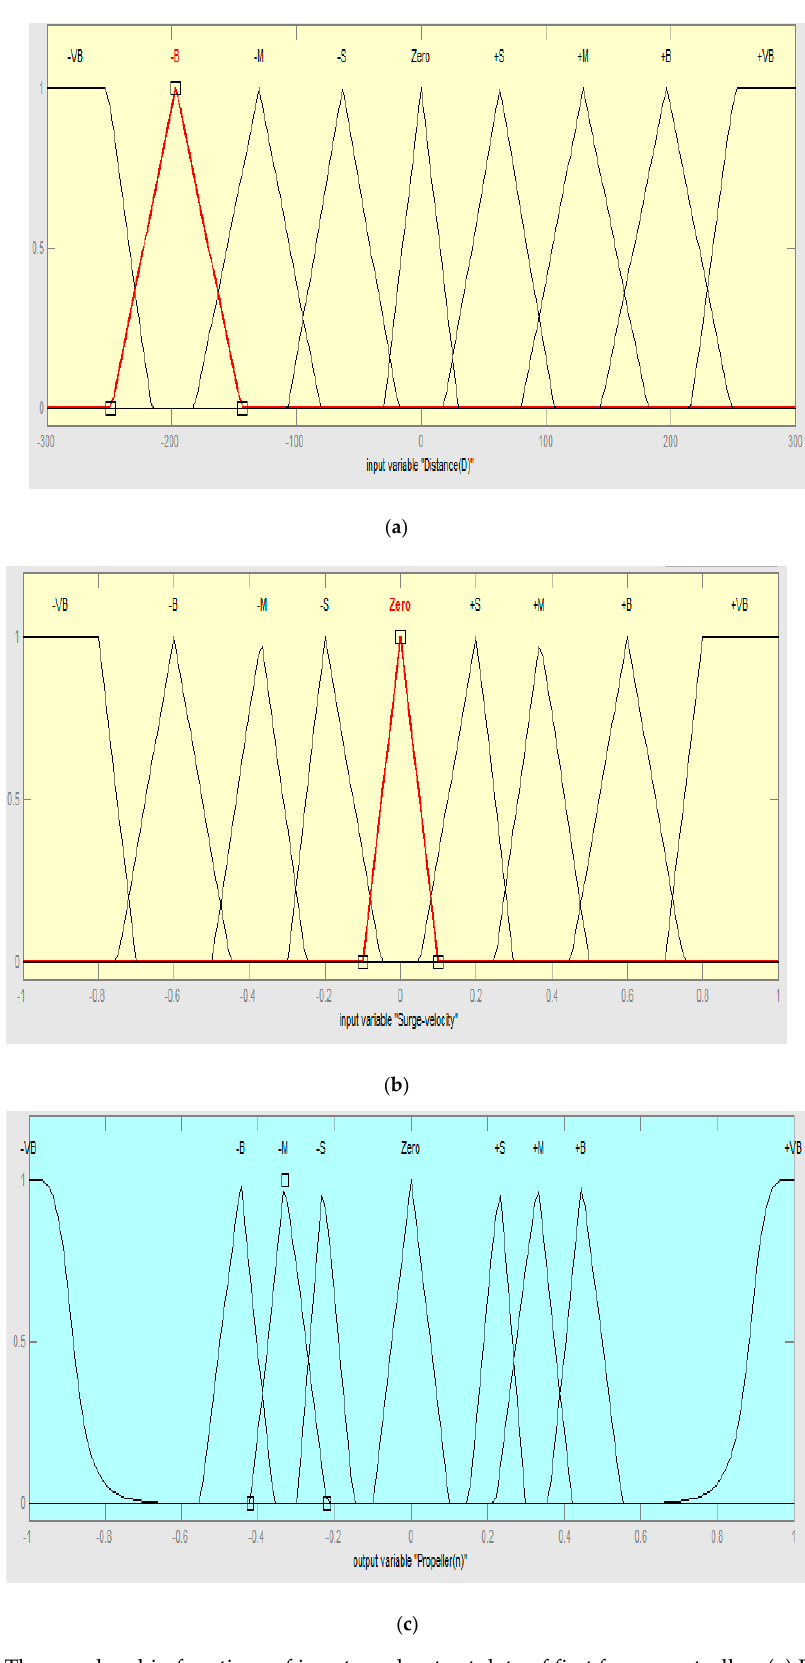
Figure 7. The membership functions of inputs and output data of first fuzzy controller: ( a ) Distance to the normal of the wharf; ( b ) surge velocity; ( c ) propeller revolution.